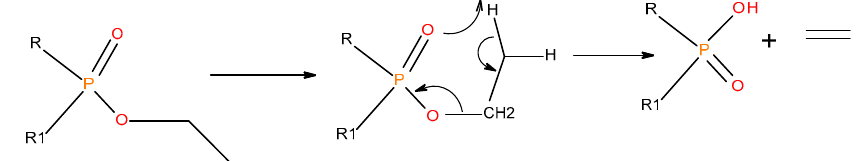
Figure 16. A general schematic diagram of production of phosphorus acidic species, in the condensed phase through the elimination of ethene from the ester side arms of the liquid additive.